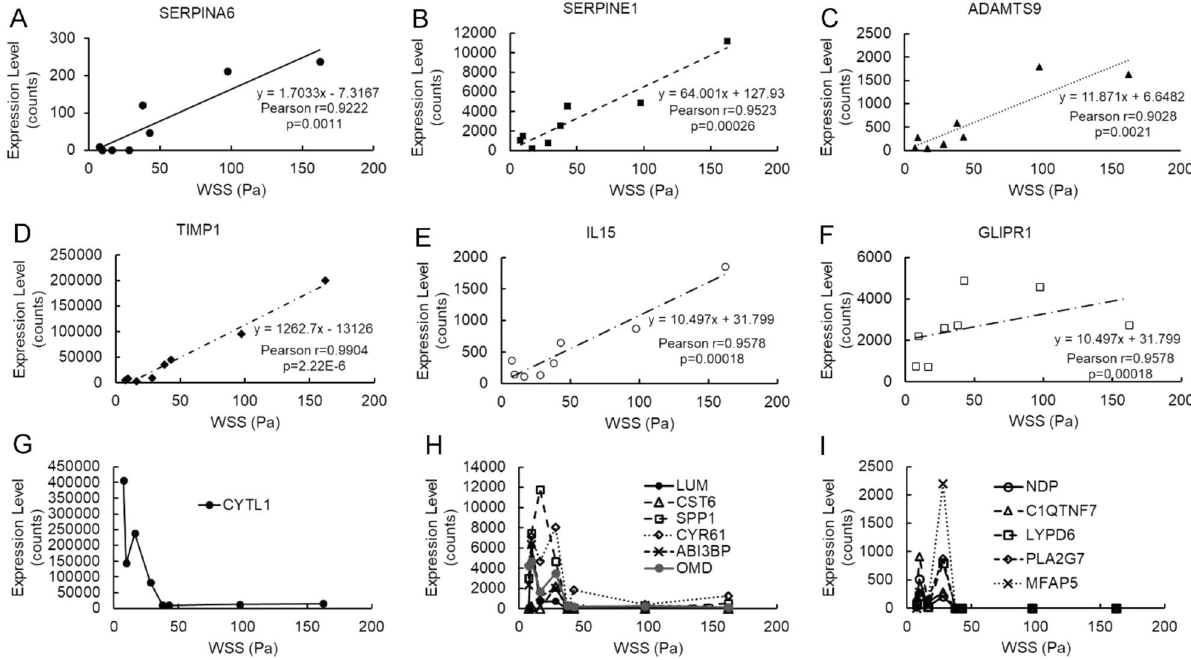
Figure 4. Gene expression as a function of local WSS. The expression levels for the 18 intimal genes with > 200 medial correlates (as determined by RNA-seq) are shown as a function of the WSS at the sample’s location (as determined by CFD). Expression levels of SERPINE6 ( A ), SERPINE1 ( B ), ADAMTS9 ( C ), TIMP1 ( D ), and IL15 ( E ) were all positively correlated with WSS over the full range of observed values (Pearson r > 0.9). GLIPR1 ( F ) increased with increasing WSS, but plateaued at WSS > 40. The remaining genes displayed very non-linear “dose–response” curves, shown in ( G ) CYTL1 , ( H ) LUM , CST6 , SSP1 , CYR61 , ABI38P and OMD, and ( I ). NDP , C1QTNF7 , LYPD6 , PLA2G7 , and MFAP5 . The maximal expression values for these 12 genes are all at WSS below 40 Pa, and expression is dramatically lower at WSS > 50